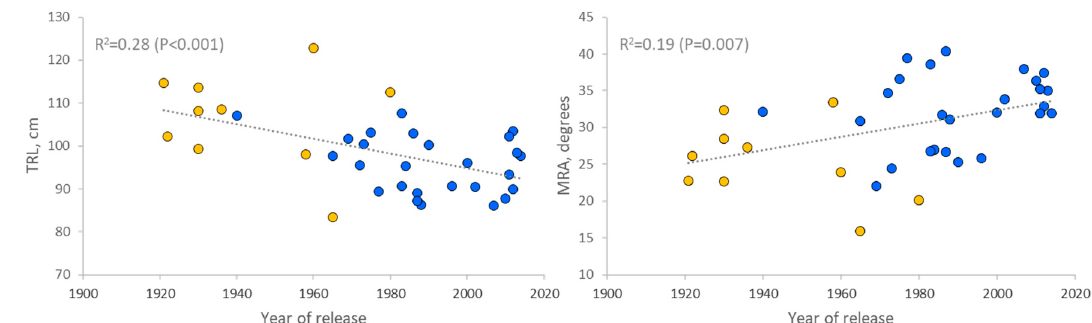
Figure 2. Time trends for total root length (TRL) and mean root angle (MRA) in seedlings of 37 durum wheat varieties. Yellow symbols correspond to landraces; blue symbols correspond to cultivars. The coefficients of determination (R 2 ) of the regression lines are indicated in each graph.